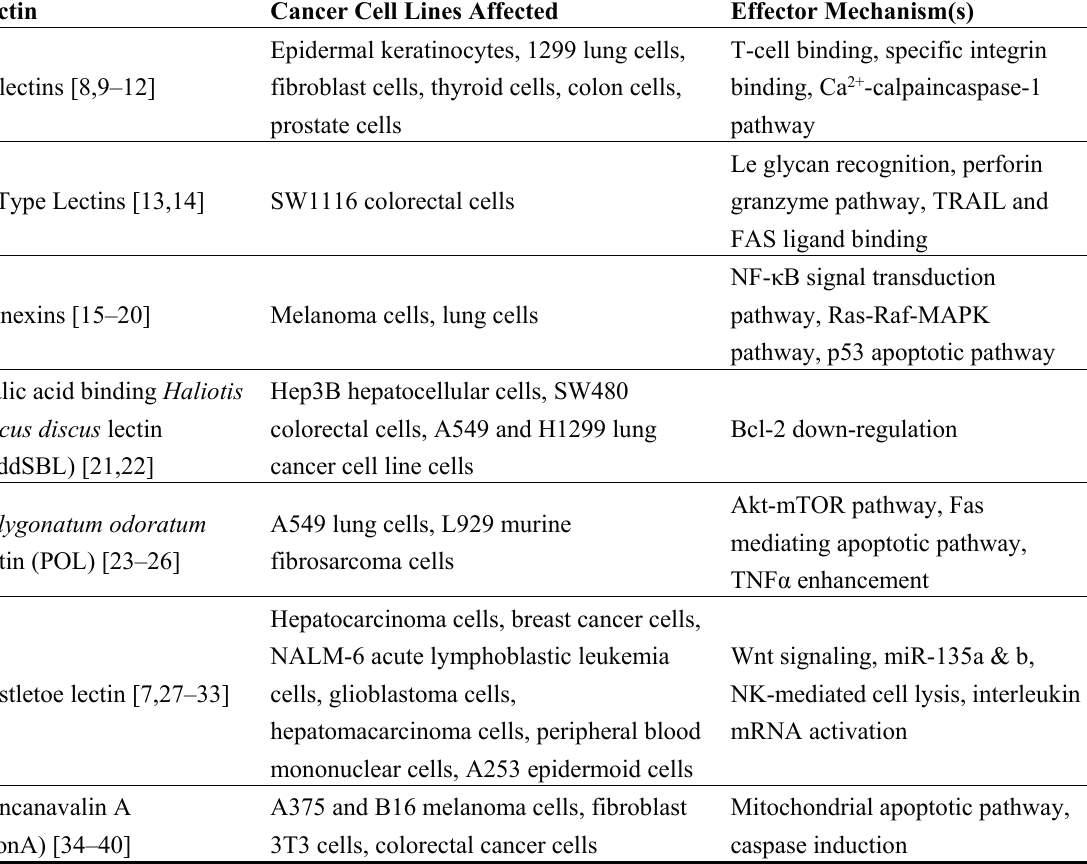
Table 1. A list of the main groups of lectins mentioned in this review including the known cancer cell lines affected by each lectin and some of the known mechanisms